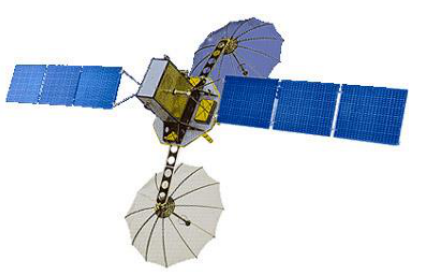
Fig. 2. Structure of hoop-type reflectors by Northrop Grumman Corporation (AstroMesh structure).